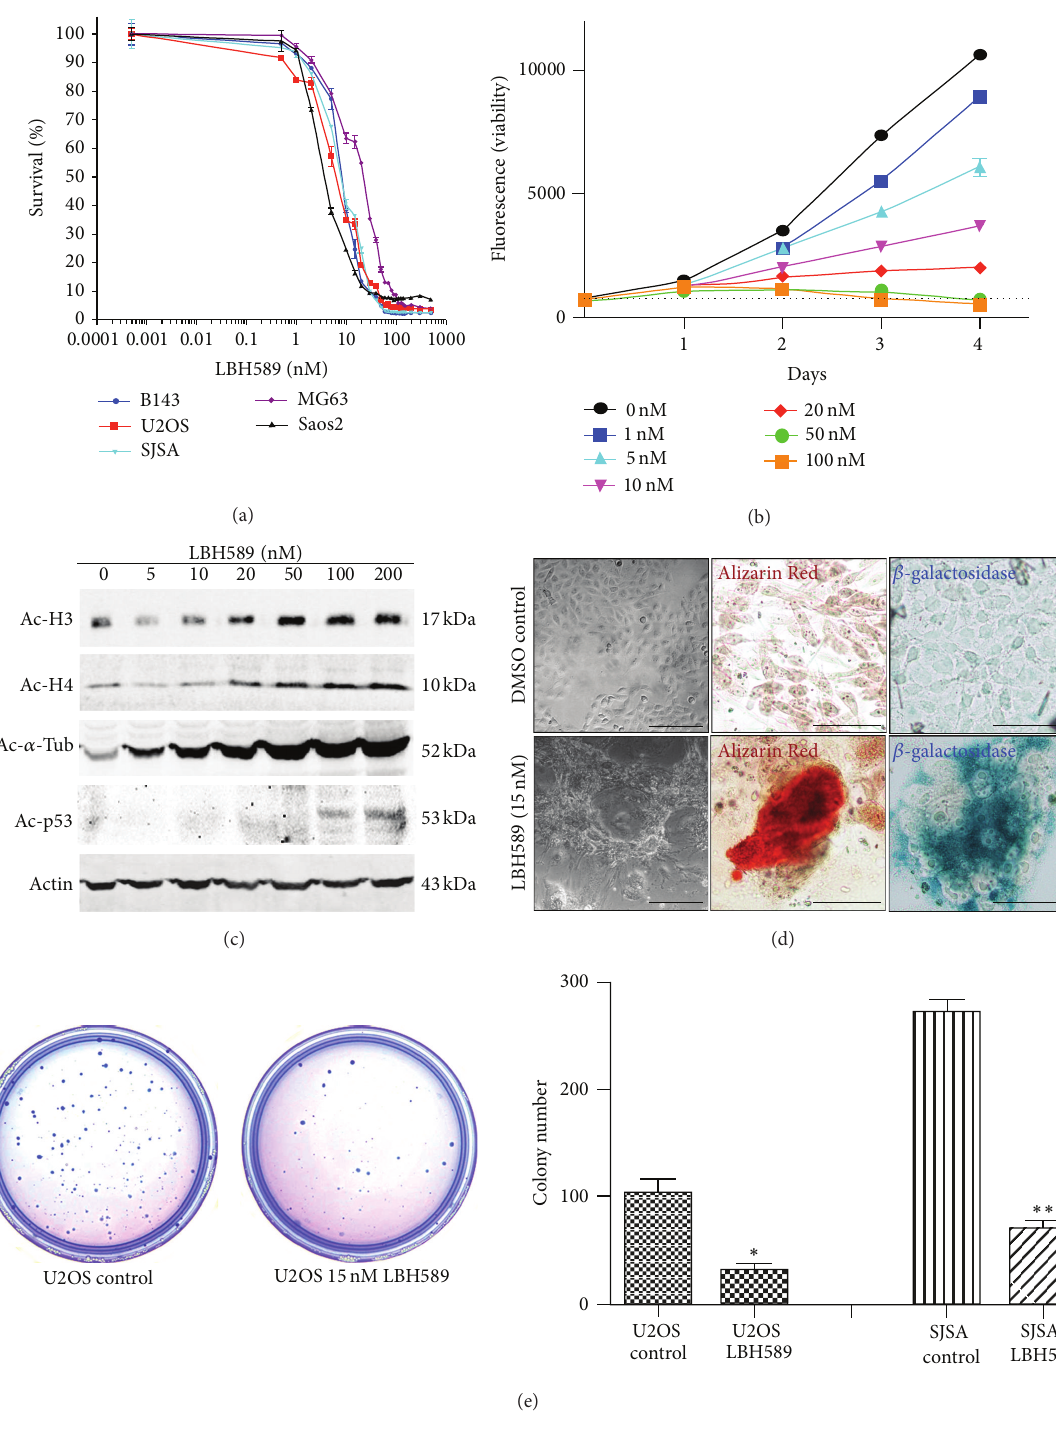
Figure 1: LBH589 inhibits cell growth and drives osteoblast differentiation of U2OS human osteosarcoma cells. (a) Survival curve of human osteosarcoma cell lines treated with increasing concentrations of LBH589. Data represent means ± SEM of quadruplicates. (b) Cell viability of U2OS cells treated with increasing concentrations of LBH589. Data represent means ± SEM of quadruplicates and dotted line = starting cell number. (c) Western blot analysis of U2OS cells with increasing concentrations of LBH589 for 24 hours. (d) Analysis of cell morphology, mineralized extracellular matrix deposition, and cellular senescence in U2OS cells treated for 21 days in 15nM LBH589 by phase contrast microscopy, Alizarin red staining, and 𝛽 -galactosidase staining, respectively. Scale bar = 500 𝜇 m. (e) Soft agar clonogenicity assay of U2OS and SJSA human osteosarcoma cells pretreated with 15nM LBH589 for 21 days. Mean ± SEM, ∗ 𝑃 < 0.05 , and ∗∗ 𝑃 < 0.01